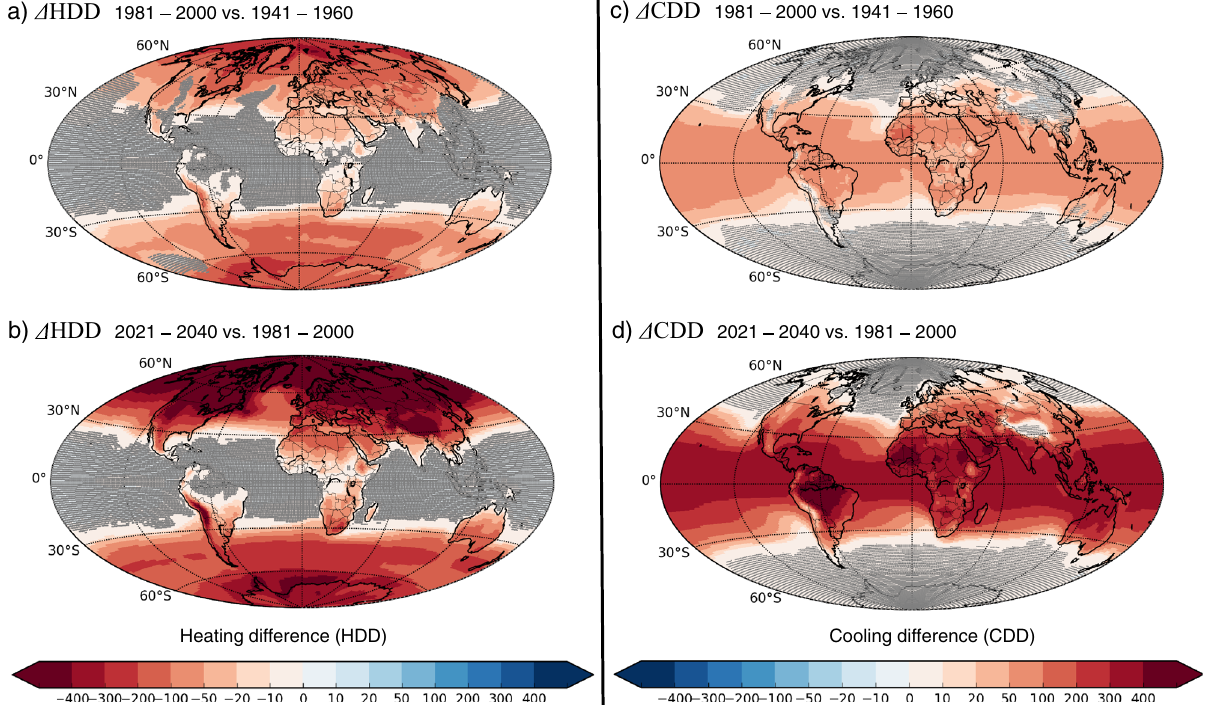
Fig. 1 Global climate-driven changes in energy demand for heating and cooling buildings. The quanti fi cation of the change is expressed as absolute differences in annual (left) Heating Degree-Days ( Δ HDD) and (right) Cooling Degree-Days ( Δ CDD) between the periods ( a, c ) 1981 – 2000 and 1941 – 1960, and ( b, d ) 2021 – 2040 and 1981 – 2000. Multi-model means of annual HDD and CDD sums were calculated using the daily mean, minimum and maximum temperatures from 30 CMIP5 models, and averaged over the 20-year periods. The areas shaded in gray indicate locations where the difference is not signi fi cantly different from zero according to Student t test at a 95% con fi dence interval. Projections are based on the RCP8.5 scenario. Note that the color scale in ( a and b ) is inverted compared to ( c and d ), so that in all panels red colors correspond to changes caused by increasing